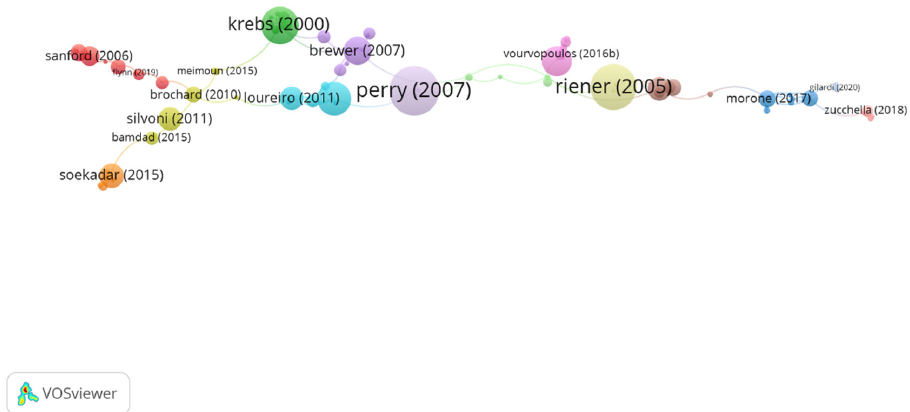
Figure 3. Clustering function in network citation about new technologies in neurorehabilitation. The most cited publication is that of Perry (2007).